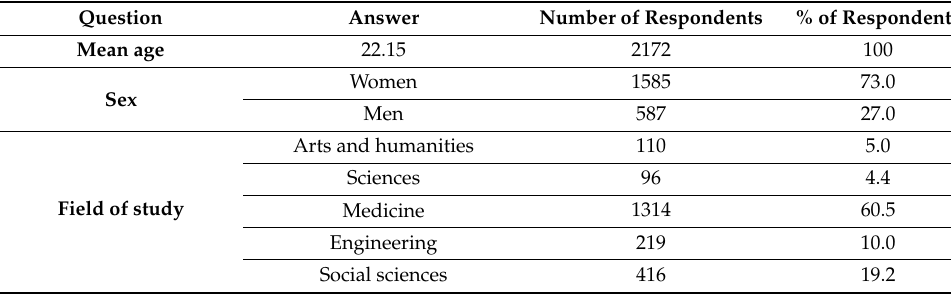
Table 1. Sociodemographic characteristics of 2172 respondents included in the